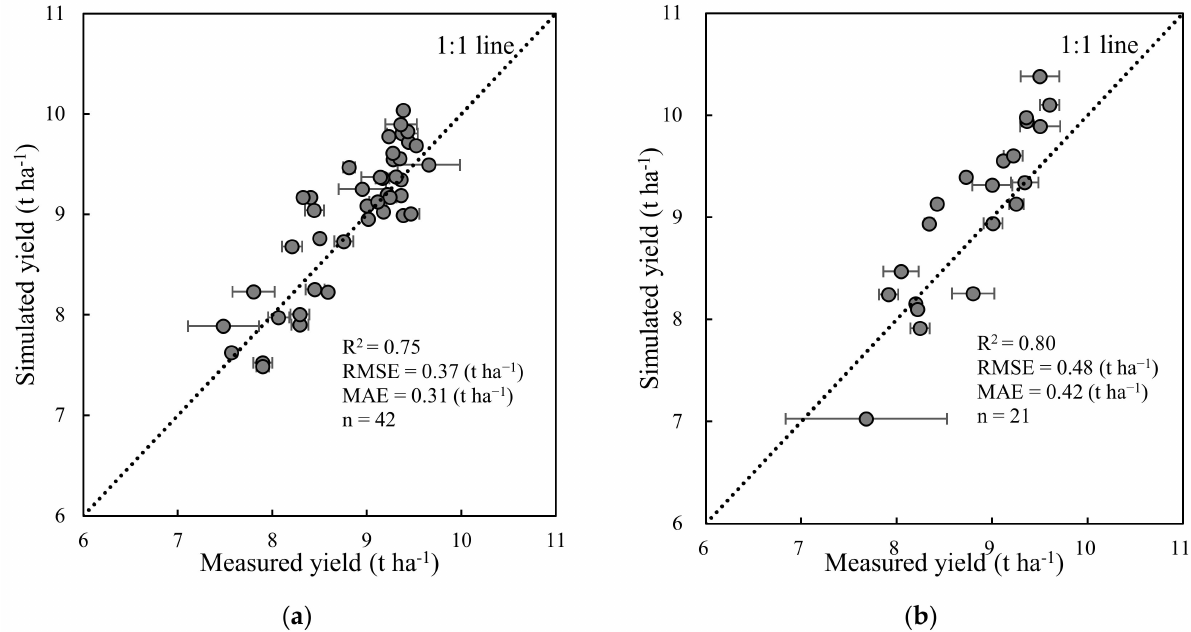
Figure 7. Measured vs. simulated yield from CERES-Rice model for 21 replicated cultivars in the calibration set ( a , in 2017 and 2018) and validation set ( b , in 2019). The horizontal error bar refers to ± one standard deviation associated with each mean in the measured yield distributions. The error bar in the CERES-Rice model was not presented here. Due to the same input data and cultivar parameters in the same cultivar with three replicates, the estimated yields obtained from the CERES-Rice model for three replicates were consistent.